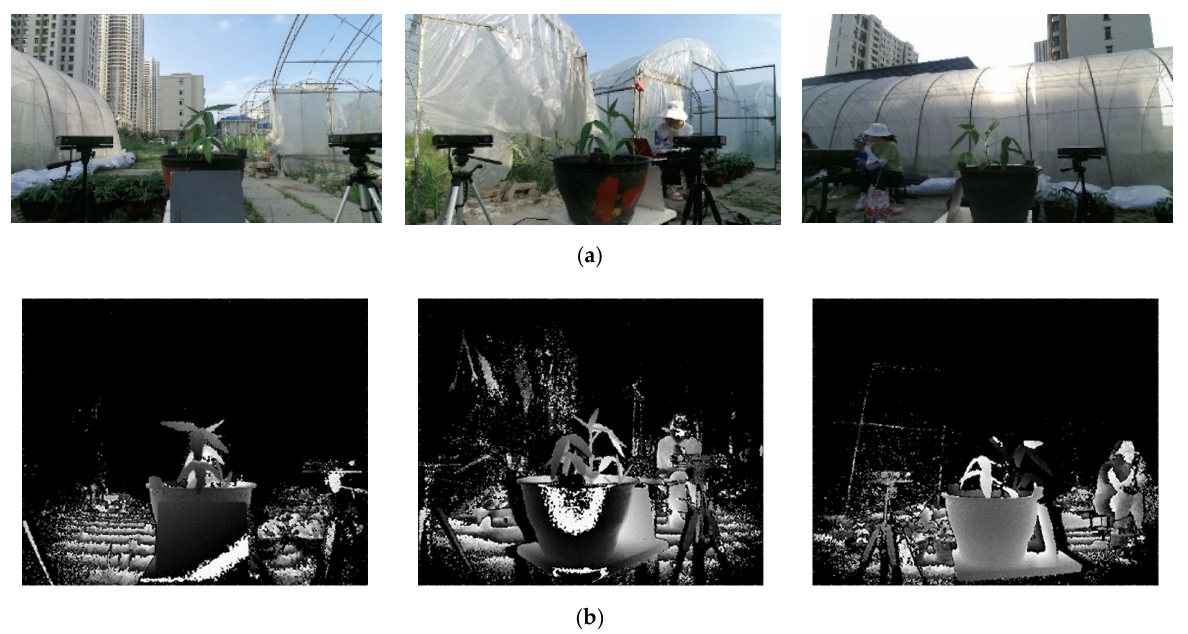
Figure 2. Color and depth maps of soybean plants in three views: ( a ) three views of the color image; ( b ) three views of the depth image.